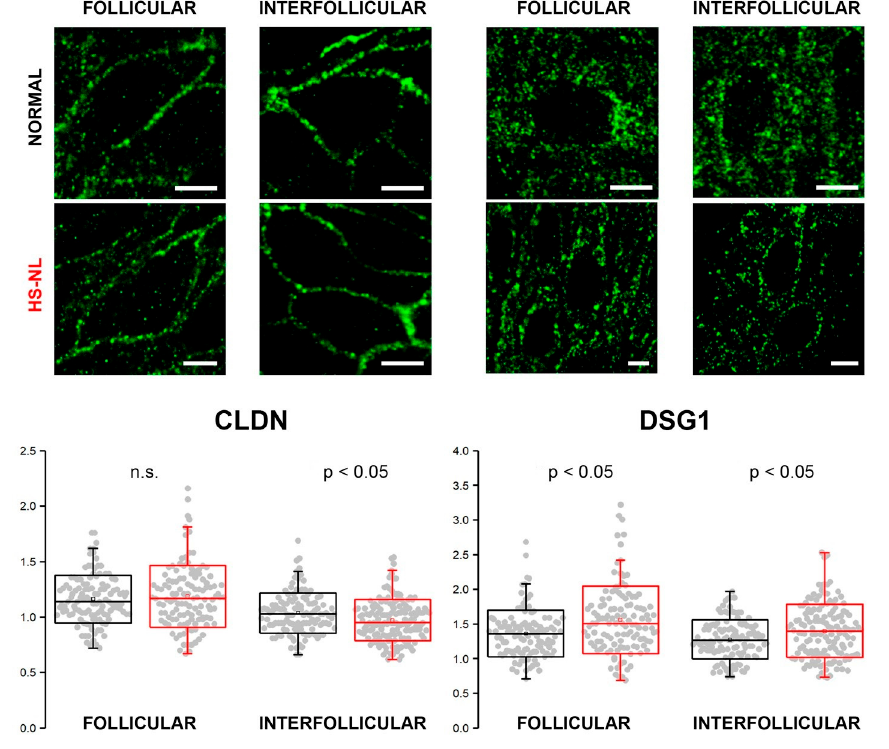
Figure 3. Representative images for immunofluorescent staining against CLDN (green; first and second columns from the left) and DSG1 (green; third and fourth column from the left) in the epidermis of normal and HS-NL (follicular and interfollicular) skin. Scale bar on all images: 5 µm. Y -axis contains inter-puncta distances in micrometers on the box-plots. n.s., not significant.